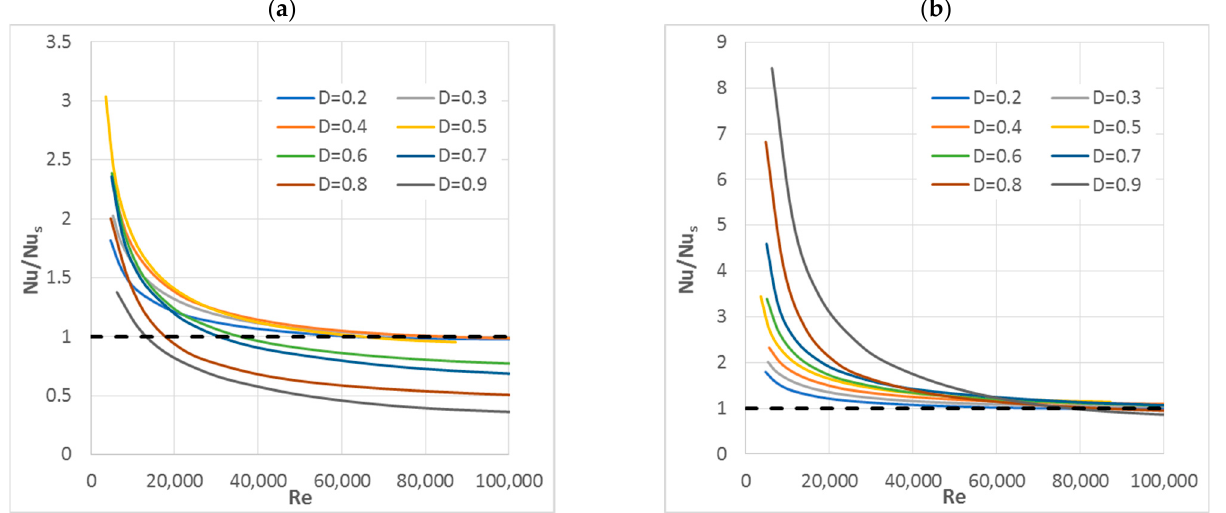
Figure 10. The ratio of the Nu number obtained from the simulation to the Nu number for a smooth pipe Nu/Nu s ( Re ), calculated for the mean volumetric temperature: ( a ) from the entire pipe, ( b ) from the annular section.